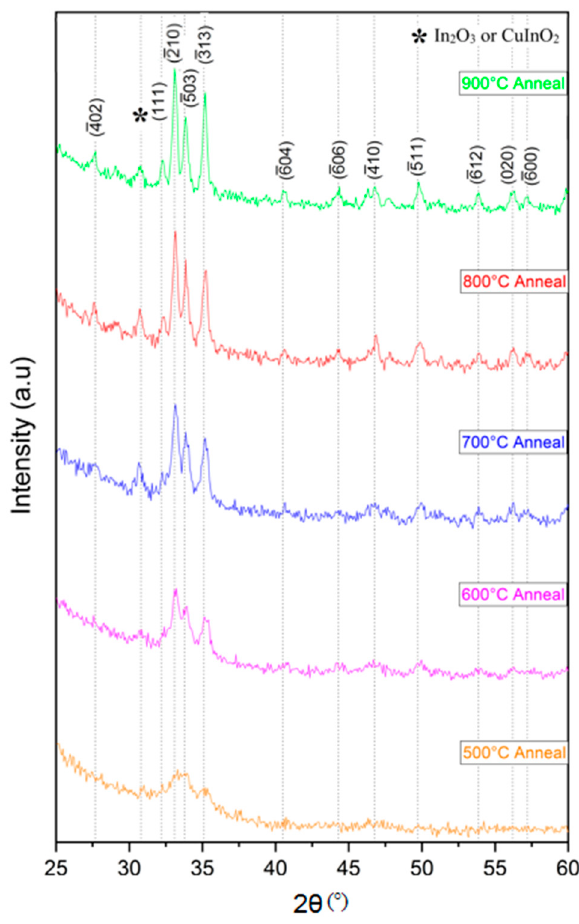
Figure 1. X-ray diffraction of the films annealed at 500–900 °C in O 2 for 90 min. The grain sizes of the films annealed at 500–900 ◦ C were calculated using the Debye– Scherrer equation